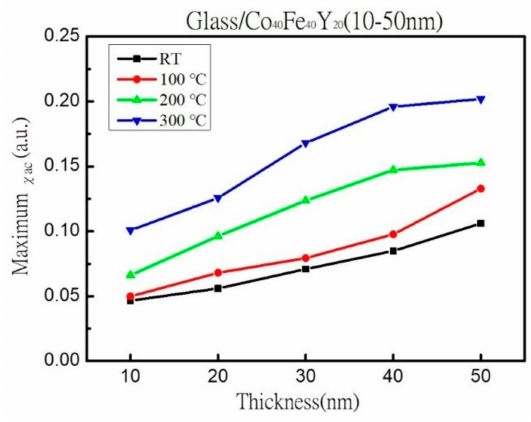
Figure 5. Maximum χ ac .